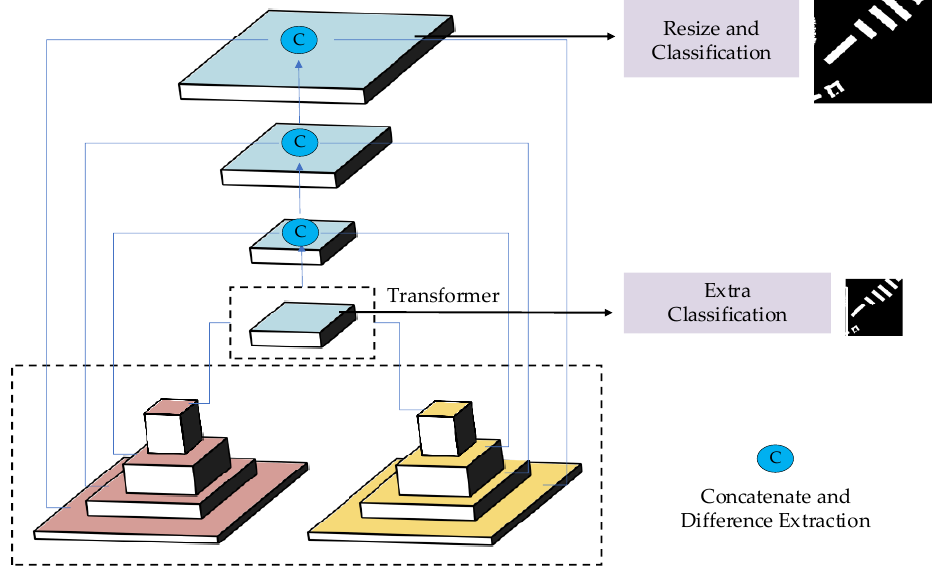
Figure 5. UNet-based feature-constrained multi-prediction network architecture.